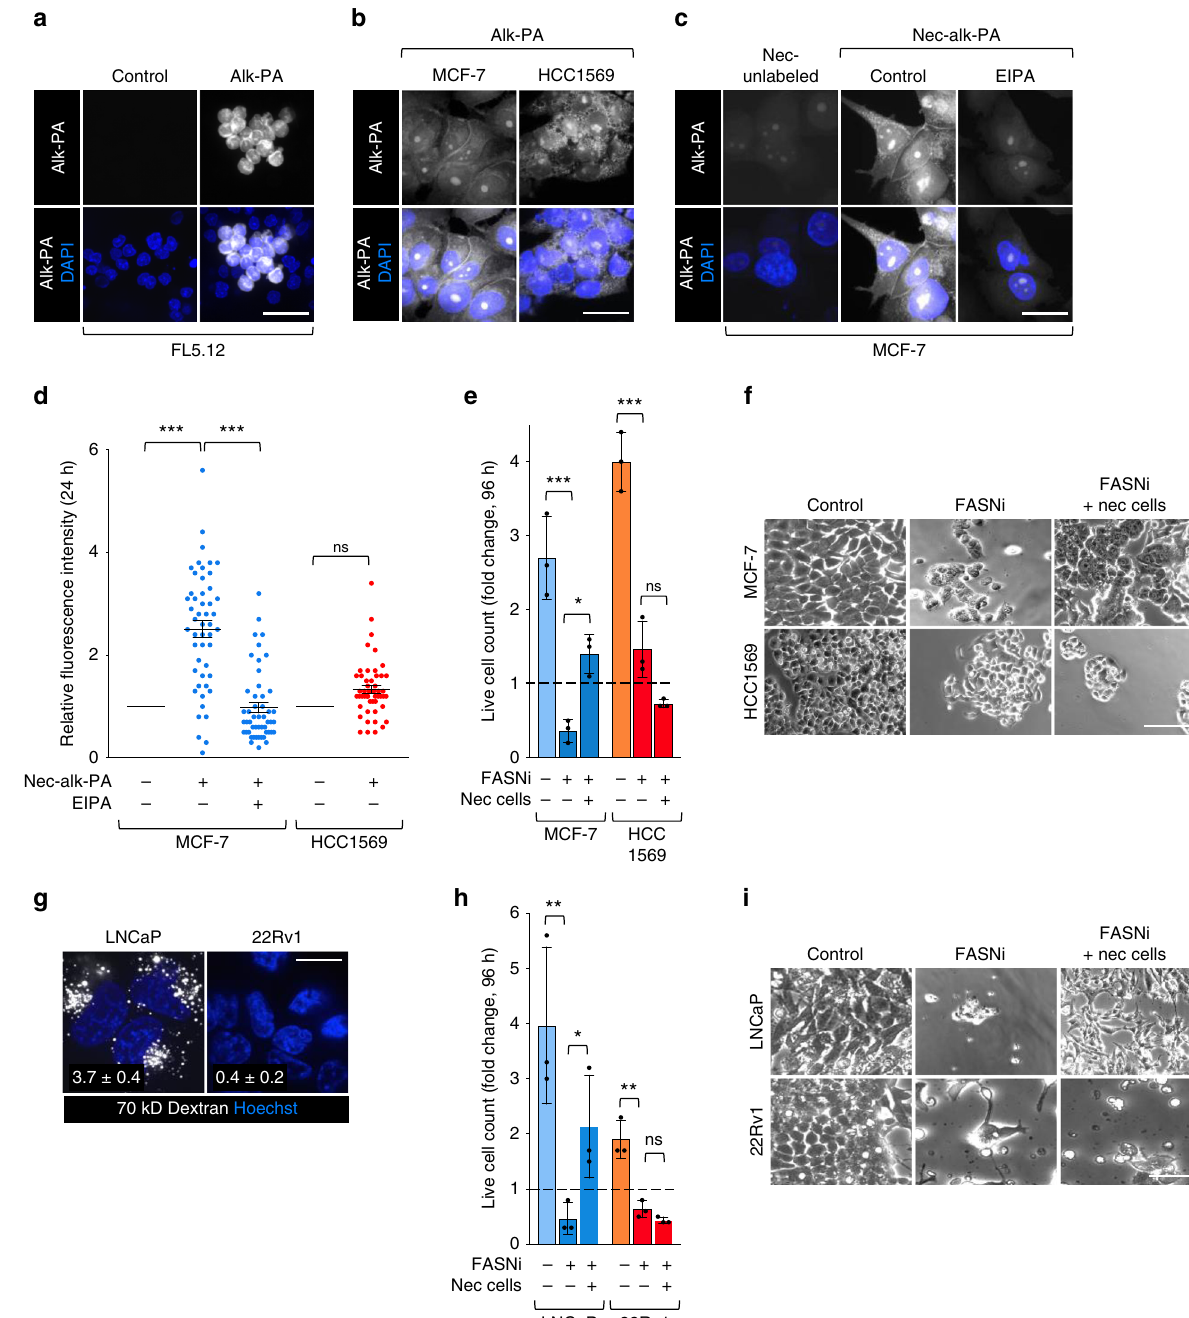
Fig. 3 Necrocytosis supplies fatty acids and confers resistance to fatty acid synthase inhibition. a FL5.12 cells labeled with alkynyl-PA in complete medium for 24 h; alk-PA detected with biotin-azide and streptavidin-Alexa488. b MCF-7 and HCC1569 cells labeled as in a . c Macropinocytic MCF-7 cells maintained for 24 h ± EIPA (50 μ M) and supplemented with unlabeled or alk-PA-labeled necrotic cell debris (nec-alk-PA). d Integrated fl uorescence intensity per cell from ( c , or Supplementary Fig. 4a) normalized to cells fed unlabeled necrotic cell debris. A total of 50 cells were quanti fi ed from two independent experiments. Using a one-way ANOVA and Tukey ’ s correction (MCF-7) or an unpaired, two-tailed t-test (HCC1569); *** P ≤ 0.001, ns,